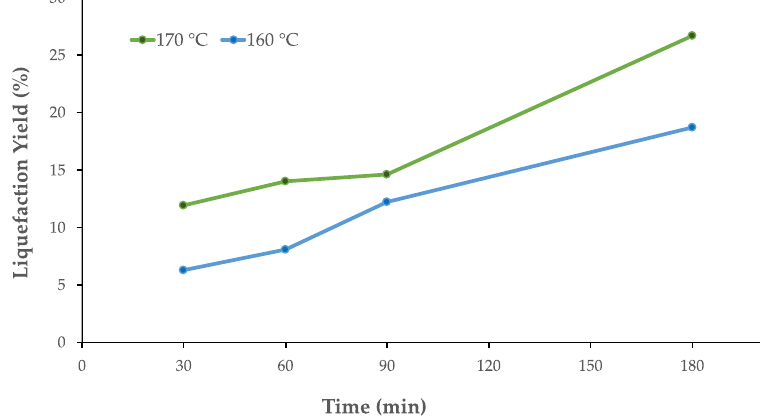
Figure 2. Pre-hydrolysis of SCS. Liquefaction yield with time.